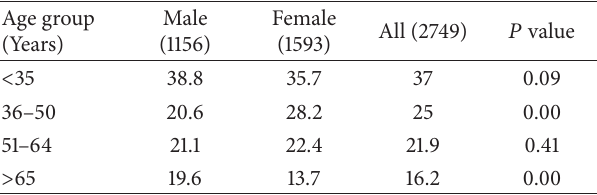
Table 1: Age and sex distribution of rural cohort for assessment of cardiovascular diseases (CVDs) risk factors in sub-Himalayan region of India, 2011.